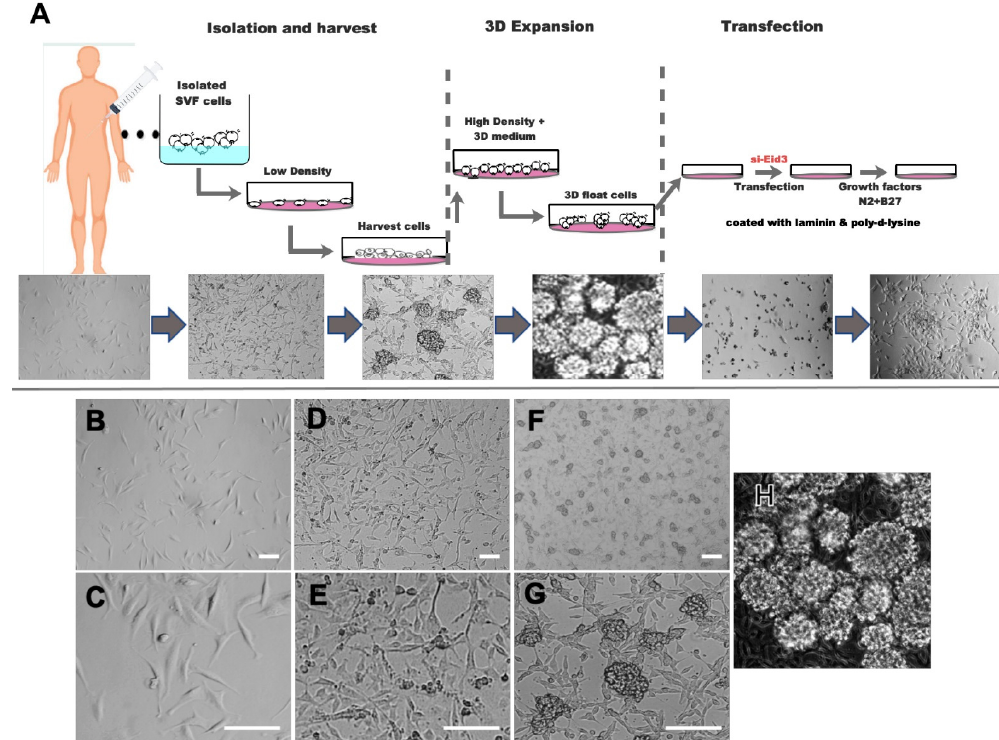
Figure 1. Schematic diagram of the strategy for 3D-cultured adipose stem cell (tdASC) transdifferentiation to neural progenitor-like cells. ( A ). Schematic diagram. tdASC form spheroids and transdifferentiate to iNPLCs. ( B–H ). Morphological observation of tdASC formation and the characterization of tdASC proliferation. Phase-contrast images of cell expansion at low density ( B , C ), high density ( D , E ), and tdASC spheres ( F , G ). Scale bars: 50 µm. ( H ). Collected tdASC spheroids. Abbreviations: ADSCs, adipose tissue-derived stromal/stem cells; SVF, stromal vascular fraction; siEID3, small interfering E1A-like inhibitor of differentiation 3.